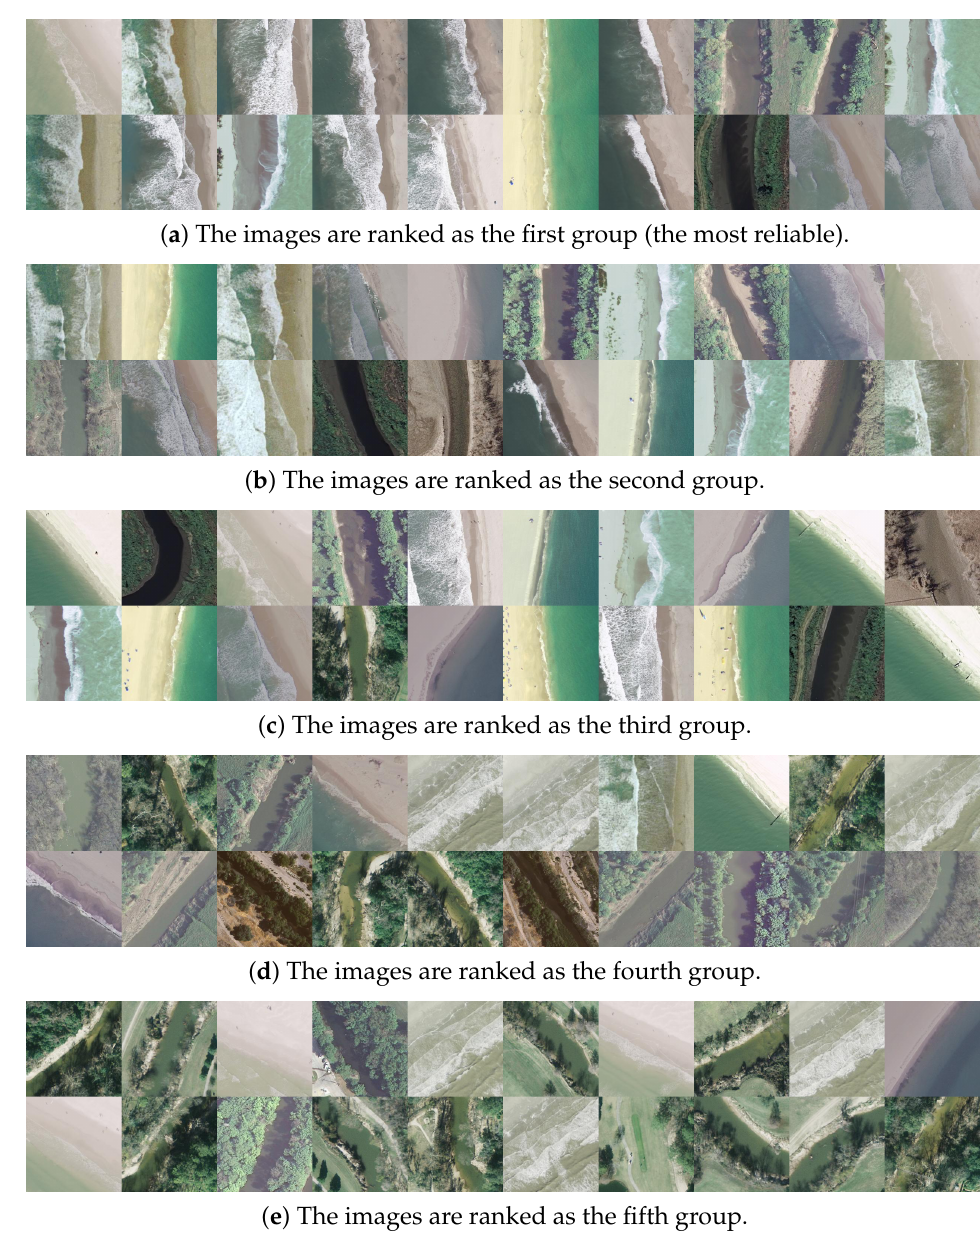
Figure A6. In the first group, there are 3 images of river and 17 images of beach. In the second group, there are 6 images of river and 14 images of beach. In the third group, there are 5 images of river and 15 images of beach. In the fourth group, there are 13 images of river and 7 images of beach. In the last group, there are 1 image of golf course, 12 images of river, and 7 images of